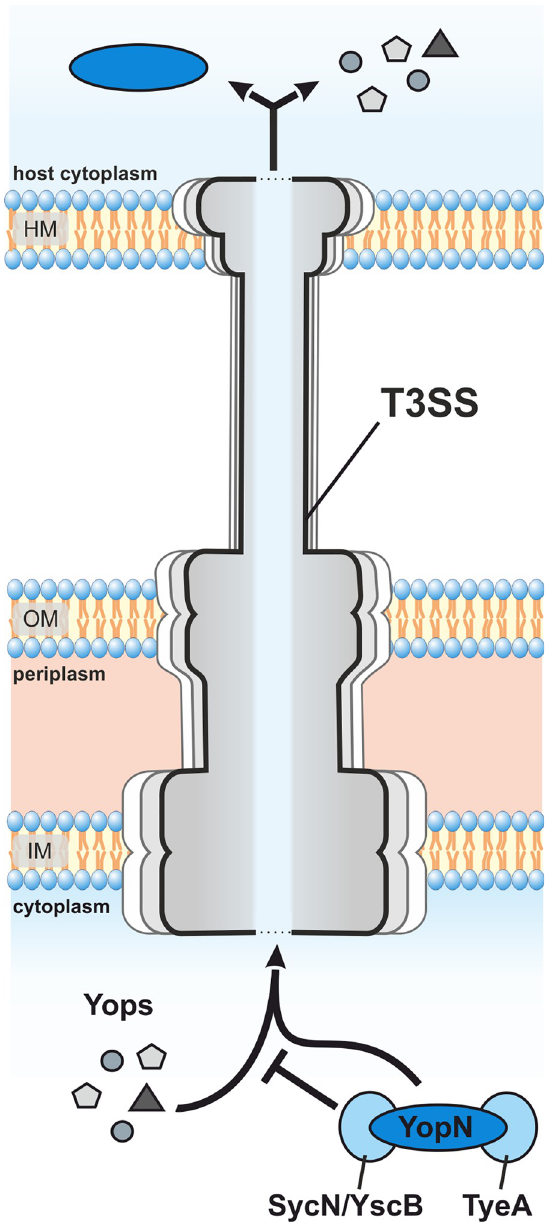
Fig 1. Schematic overview of YopN-regulated Yop secretion in Yersinia . The secretion of effector proteins (Yops) that modulate the host immune system are controlled by the YopN-TyeA-SycN-YscB complex. YopN and TyeA block secretion in concert with the chaperone complex SycN/YscB [20,22].Dissociation of the plug is assumed to occur through depletion of calcium and after host cell contact resulting in the SycN/YscB-controlled secretion of YopN itself [23,26,27]. HM: host membrane; OM: outer membrane; IM: inner membrane.